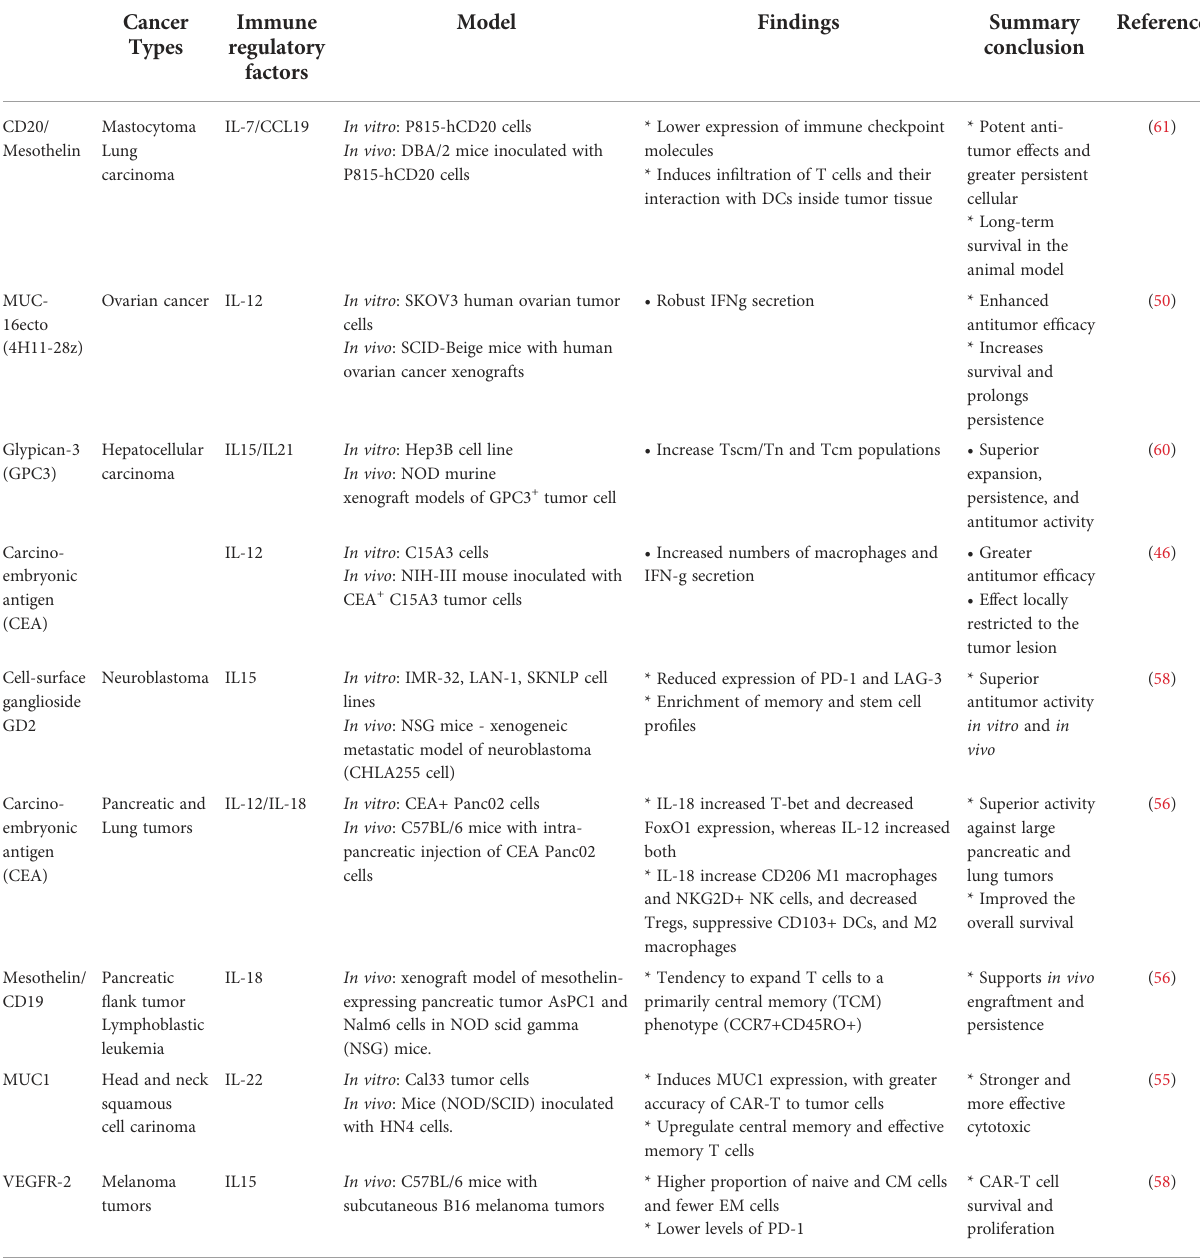
TABLE 1 Preclinical studies with TRUCKs